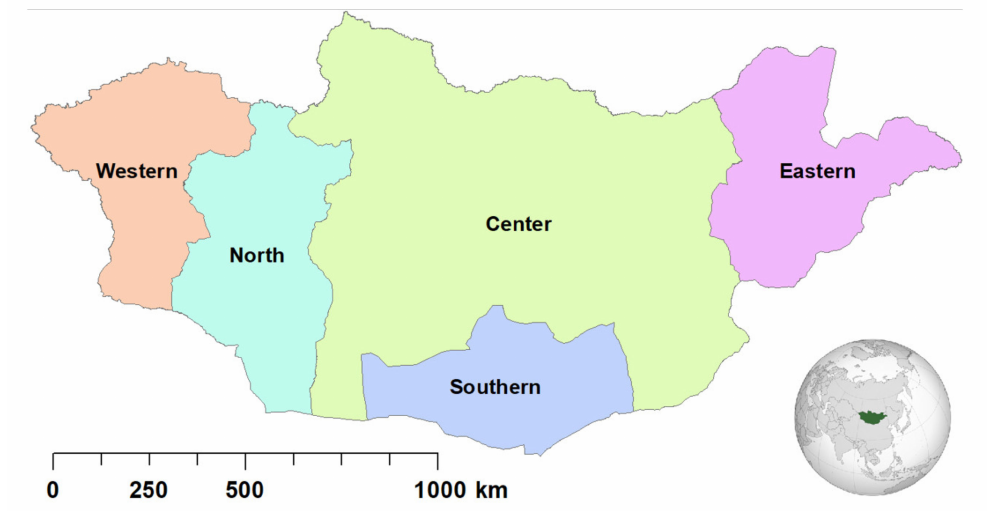
Figure 1. Map of